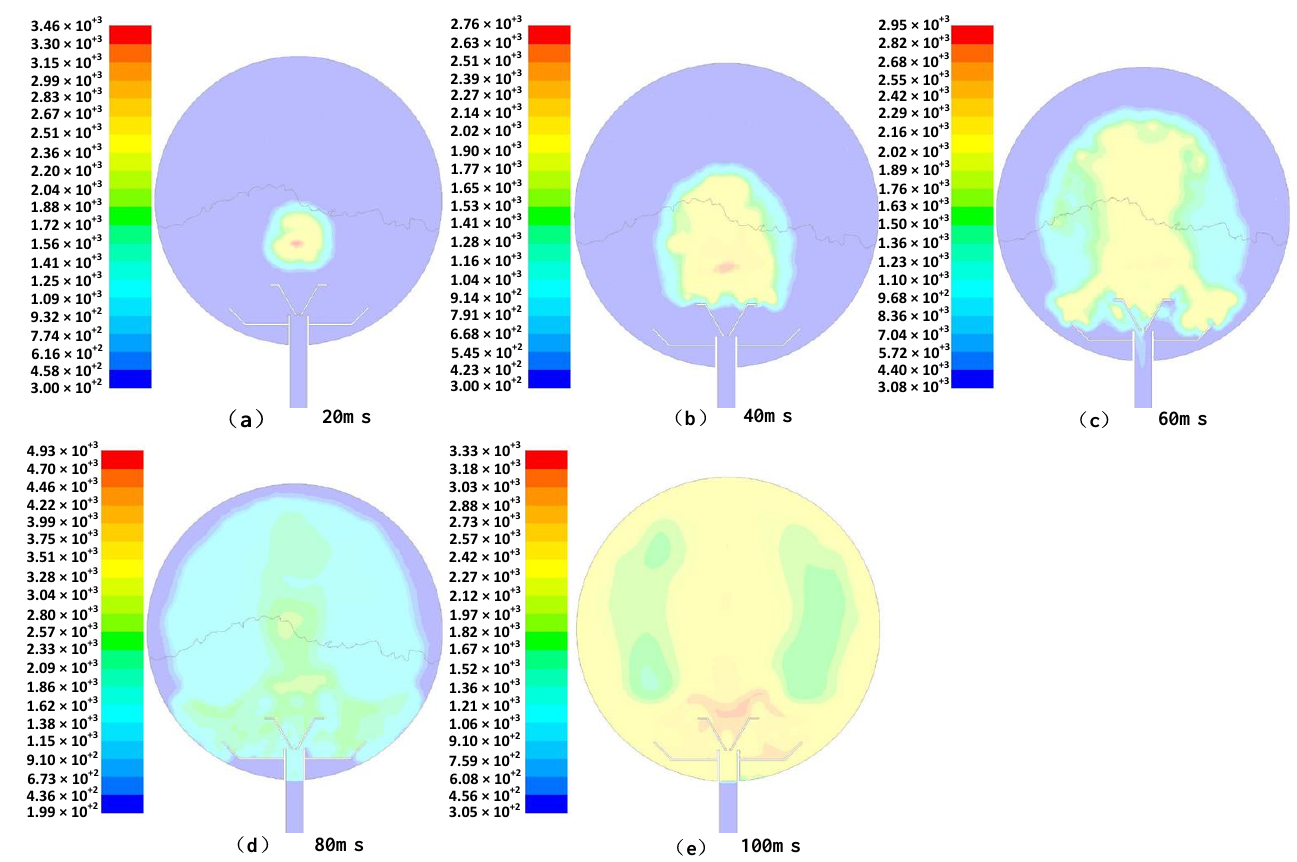
Figure 9. Traces of dust activity before ignition and explosion.